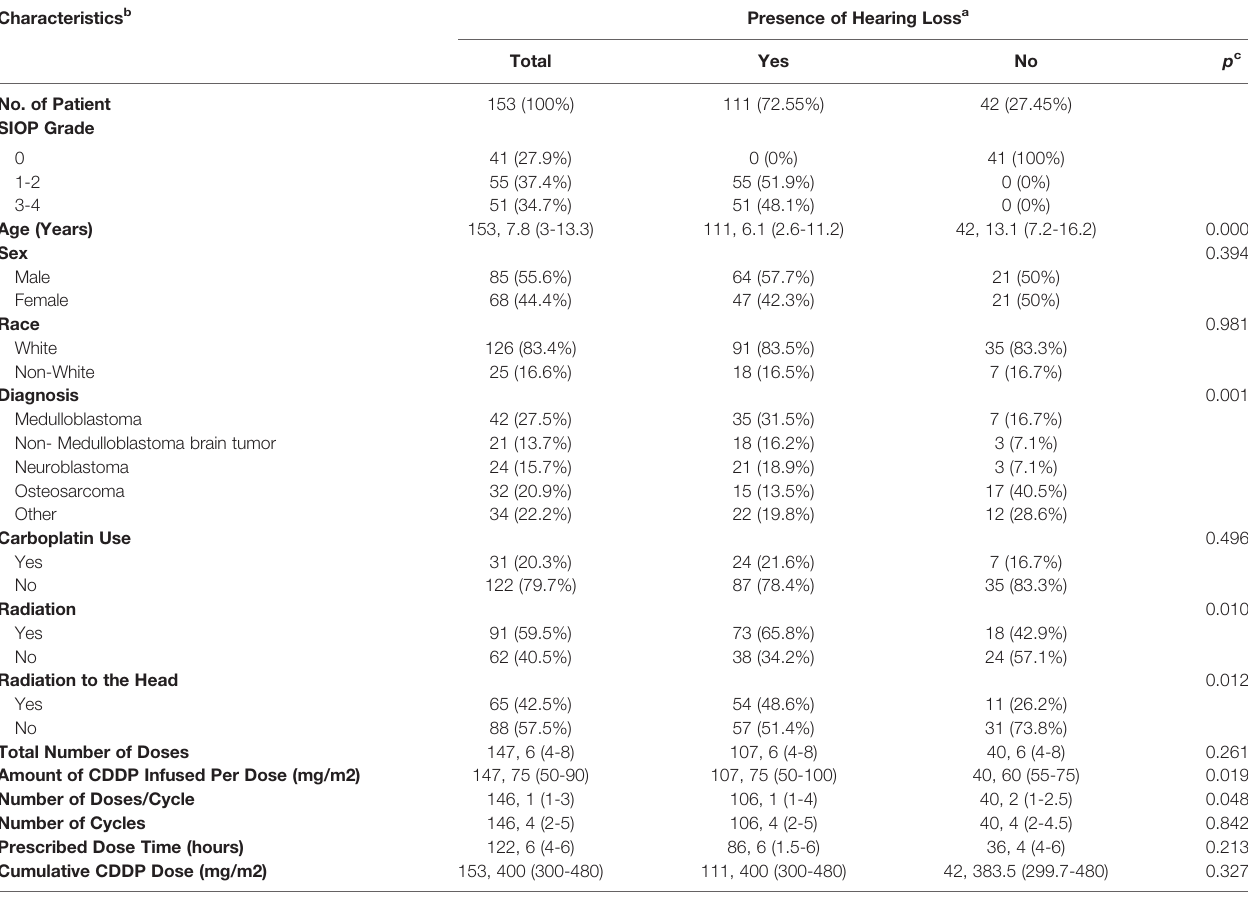
TABLE 1 | Patient and treatment characteristics by the presence of hearing